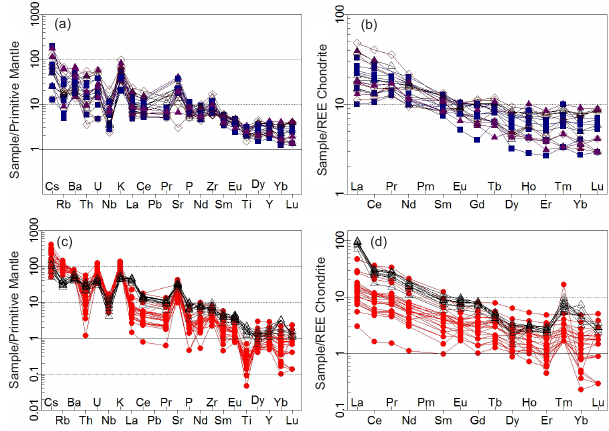
Fig. 7 Figure 7. Normalized REE and trace element patterns for the north- ern (a, b) and southern (c, d) subvolcanic rocks. Primitive-mantle and chondrite data are from Sun and McDonough